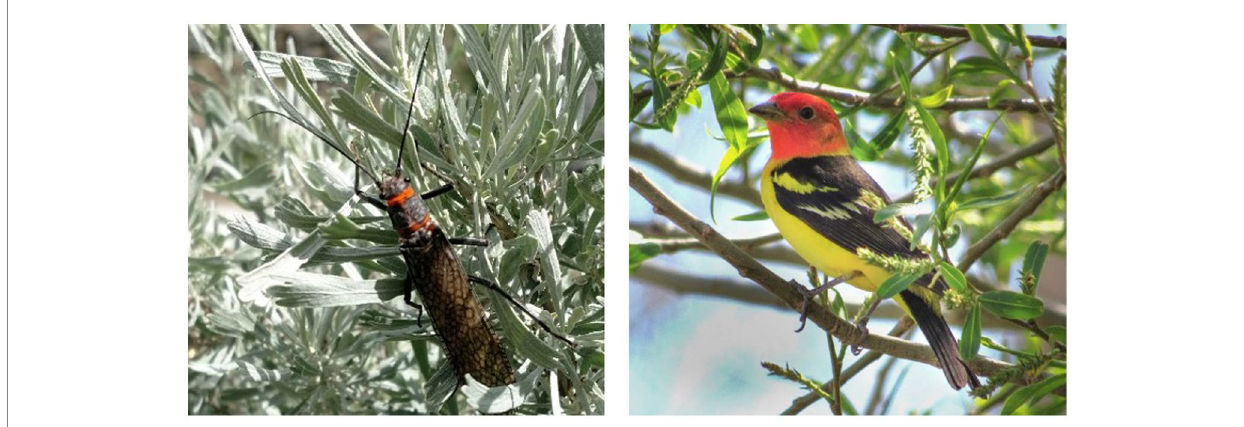
FIGURE 1 (Left) An adult giant salmonfly Pteronarcys californica recently emerged from the mainstem of the Salmon River, Idaho (photo by Colden Baxter). (Right) A male western tanager, Piranga ludoviciana , one of the species of birds frequently observed feeding on adult salmonflies in this study (photo by Austin